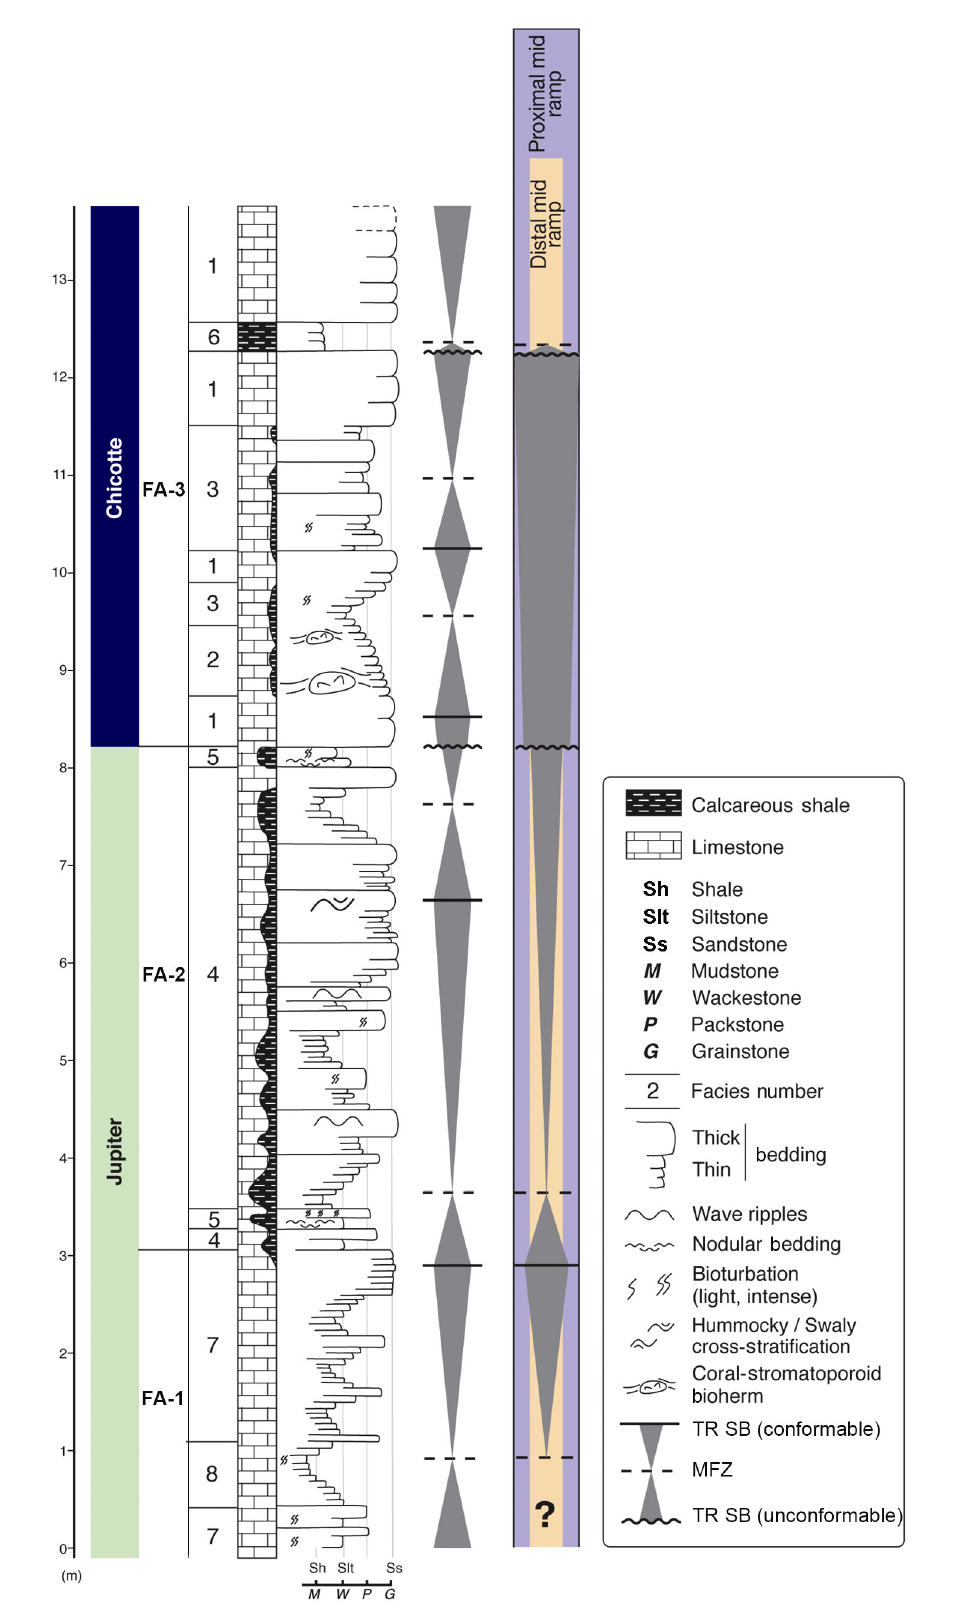
Fig. 3. Detailed stratigraphic log of the Jumpers section with facies, cycles and sequence distribution (see text for